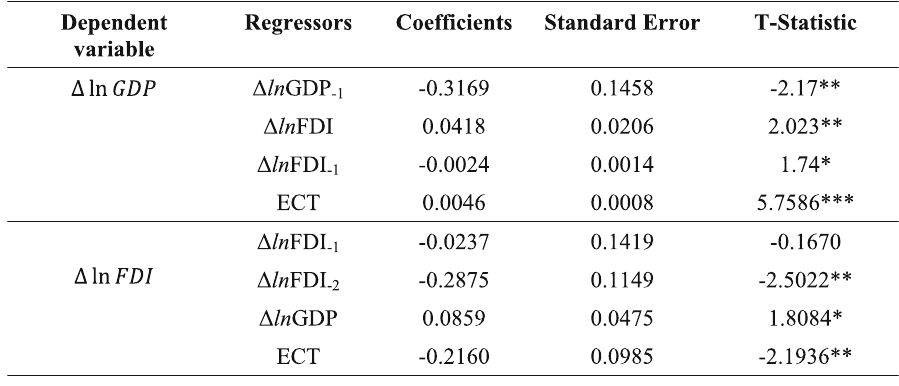
Table 5 Augmented ARDL short-run and ECM results